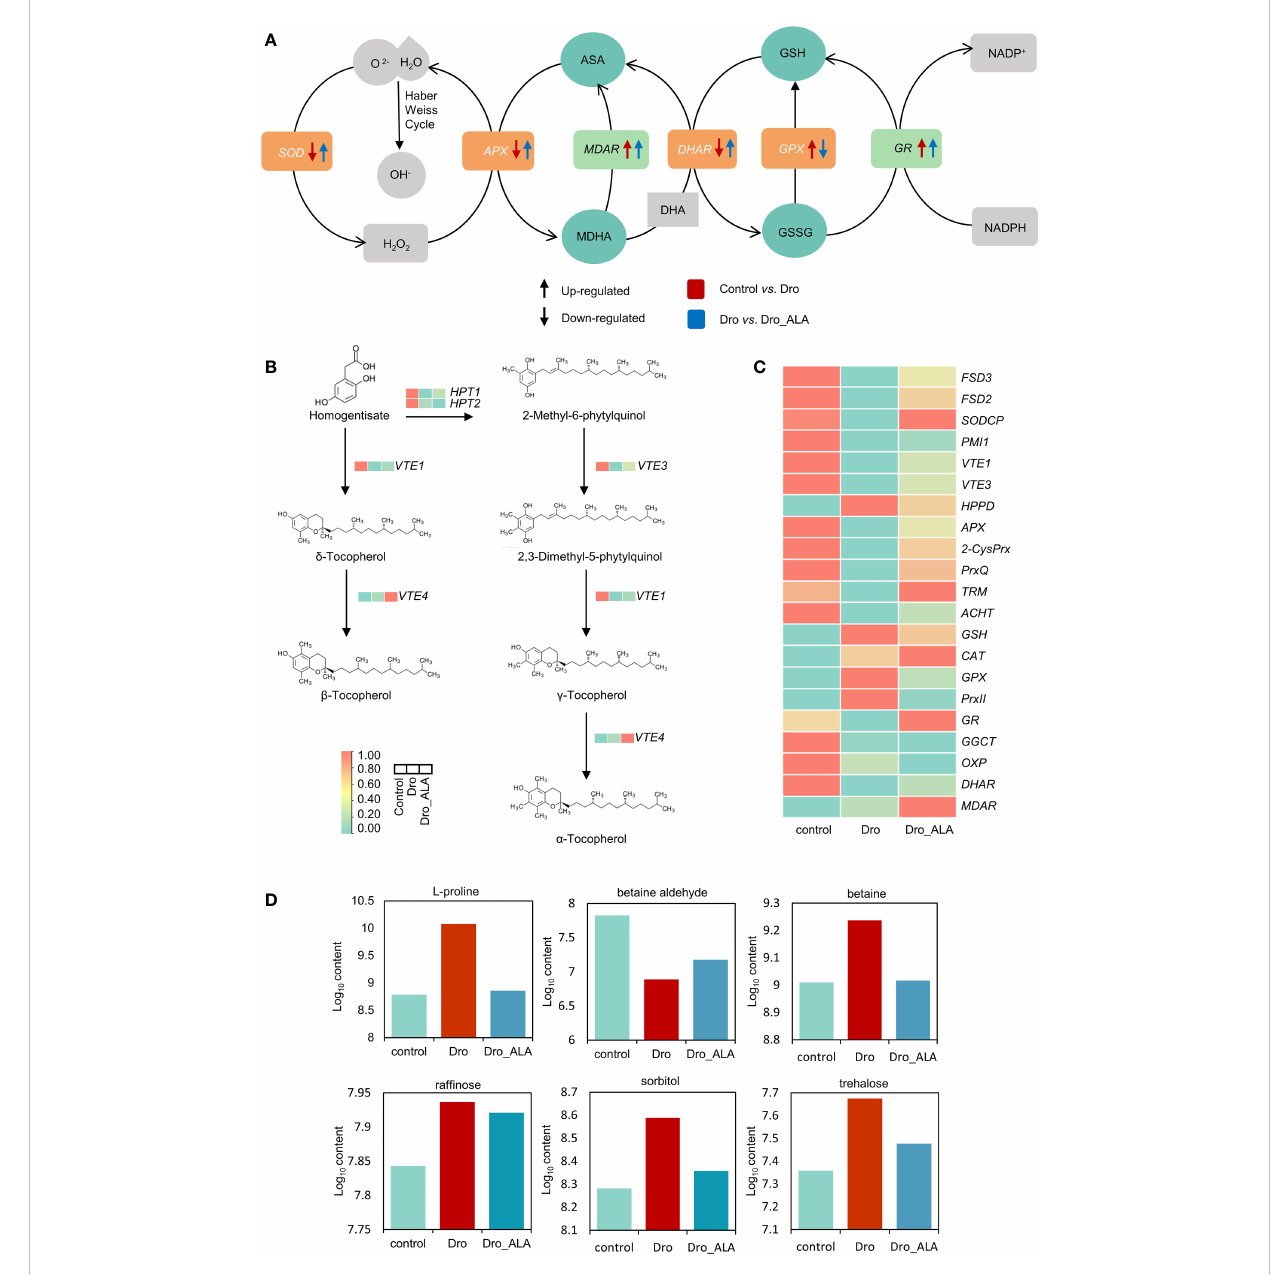
FIGURE 4 Cellular homeostasis under drought treatment and drought plus ALA treatment. (A) AsA-GSH cycle of grapevine leaves under drought stress and drought plus 5-aminolevulinic acid treatments, Arrows ( ↑ ) and ( ↓ ) represent up-regulation and down-regulation, respectively. Red and blue represent control vs . Dro and Dro vs . Dro_ALA groups, respectively. (B) Biosynthesis of tocopherol in grapevine leaves under control, under drought stress and drought plus 5-aminolevulinic acid treatments. Red and green represent higher and lower expression, respectively. (C) Information of DEGs related to antioxidant system of grapevine in control, Dro and Dro _ALA. (D) Information of important DAMs related to osmotic regulation and autophagy of grapevine in control, Dro and Dro _ALA. (Dro represents drought treatment; Dro_ALA represents drought plus 5-aminolevulinic acid